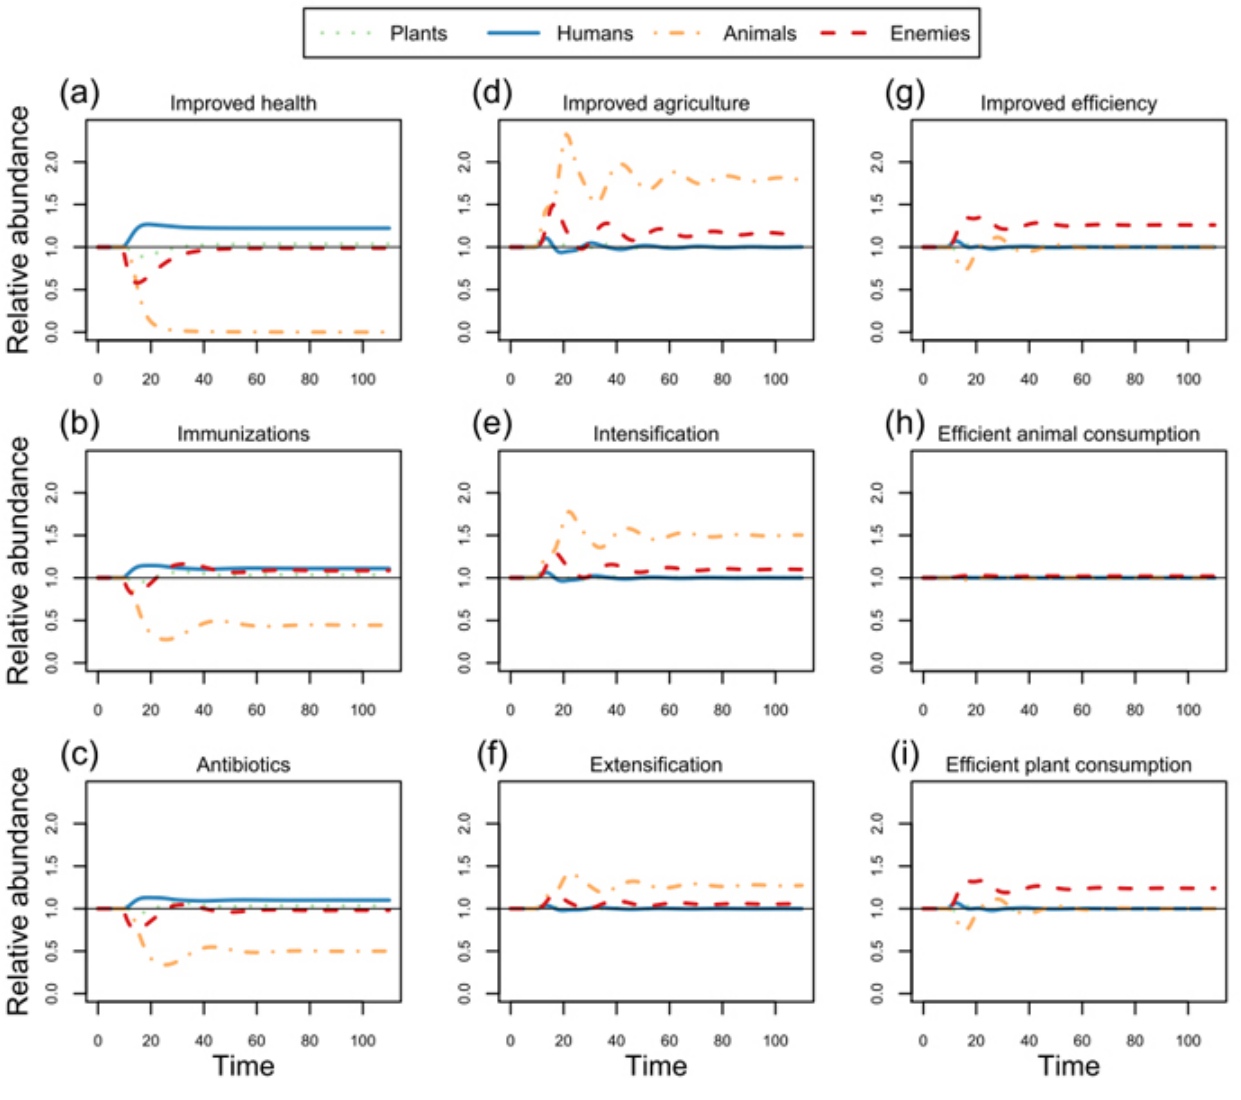
Fig. 1 . Effects of improvements in health (a-c), agriculture (d-f), or efficiency (g-i) on the abundances of humans, plant and animal resources, and natural enemies. All state variables were at equilibrium from time 0 to 10, and are shown relative to these equilibrium values. Initial parameter values satisfied the feasibility conditions: c = r = K = 1. At time 10, and thereafter, parameters of interest were changed by 10%. For example, c consider the effects of decreasing the rate that humans were attacked by enemies (b), or m the effects of increasing the mortality rate of enemies (c), or both health improvements occurred simultaneously (a). All other parameters remained constant over time. Table 2 indicates parameters of interest and direction of change for each